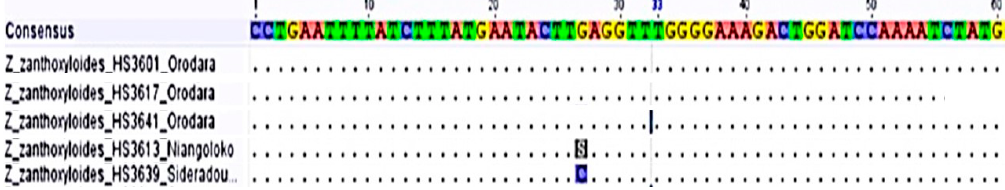
Figure 6. GBSSI alignment of Z. zanthoxyloides (partly).